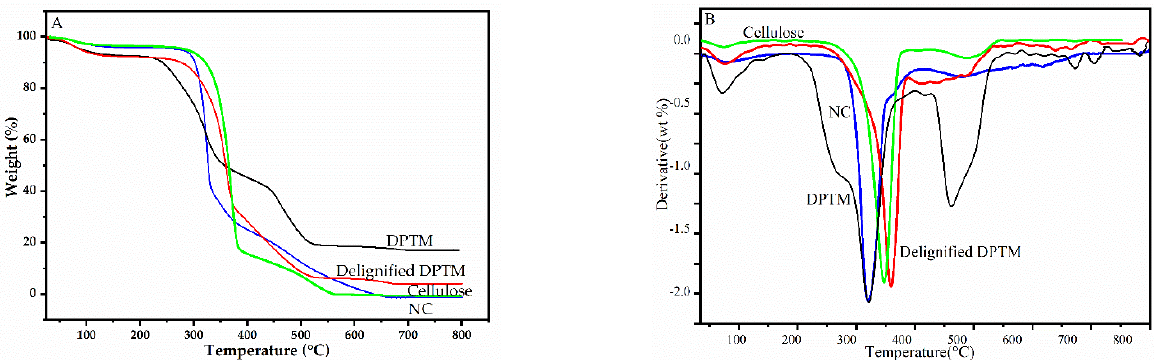
Figure 3. Thermogravimetric curve ( A ) and derivative thermogravimetric curve ( B ) of DPTM, delignified DPTM, cellulose and nanocellulose samples.